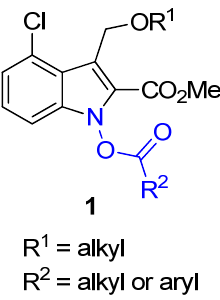
Figure 2. Structure of multisubstituted 1 ‐ acyloxyindoles 1 .